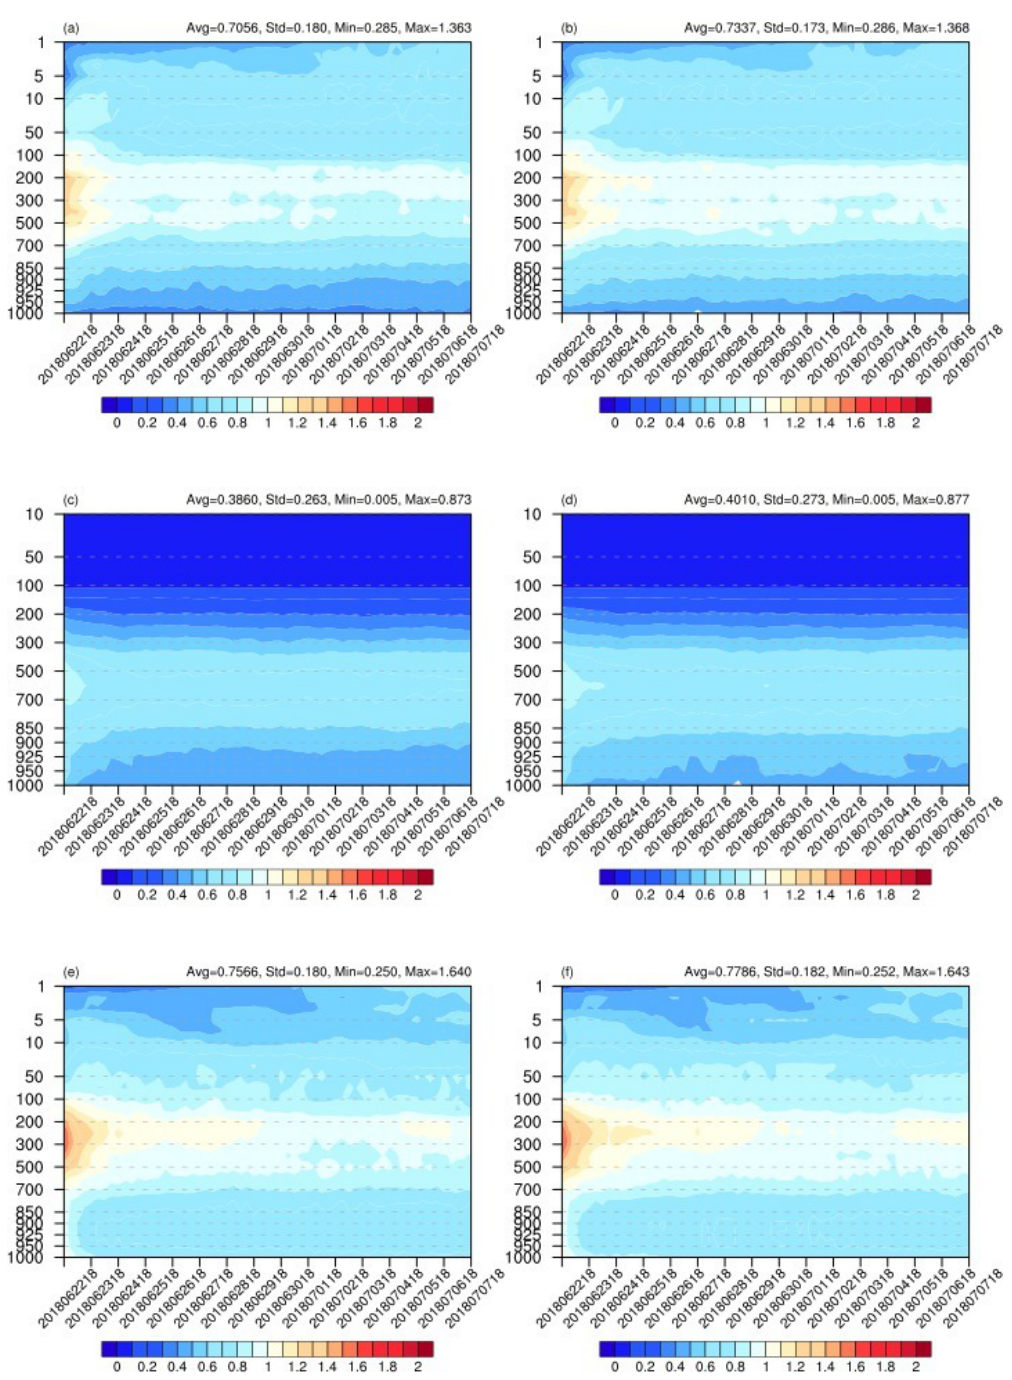
Figure 5. Time series of the reliability index γ for CTL (left panels) and STO (right panels): ( a , b ) temperature (in K), ( c , d ) specific humidity (in g kg − 1 ), and ( e , f ) zonal wind (in m s − 1